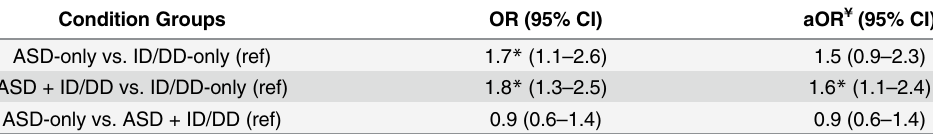
Table 3. Between-group Comparisons of the Odds of Any Elopement within the Previous 12